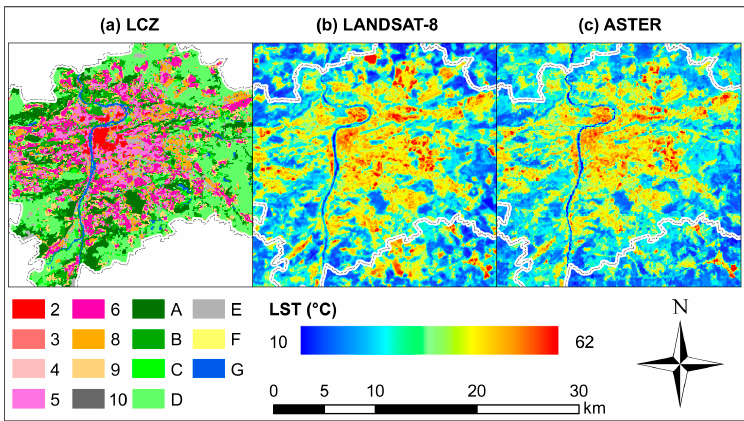
Figure 5. ( a ) Spatial distribution of LCZs and examples of ( b ) LANDSAT-8, scene LT8_20130618, and ( c ) ASTER, scene AST_20130806; LST variability in the Brno area; see Table 3 for the scene ID. LCZ